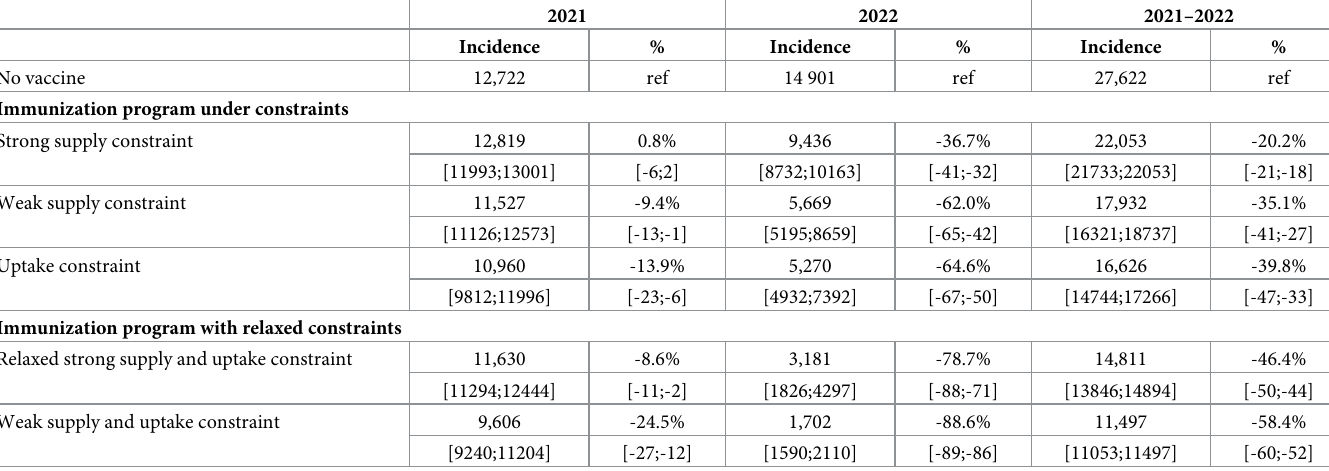
Table 2. Cumulative incidence of COVID-19 hospitalization per million population and percentage reduction in hospitalization rates for immunisation programs with and without relaxation of uptake and supply constraints compared to no vaccination,